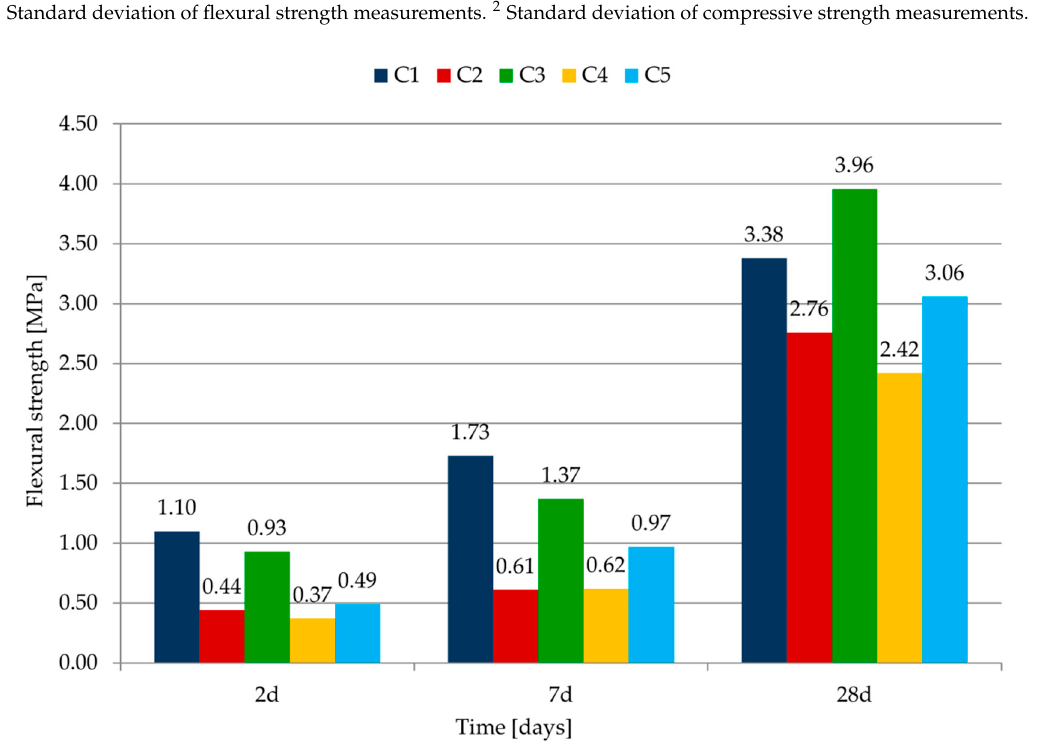
Table 7. Average strength of the mortars.